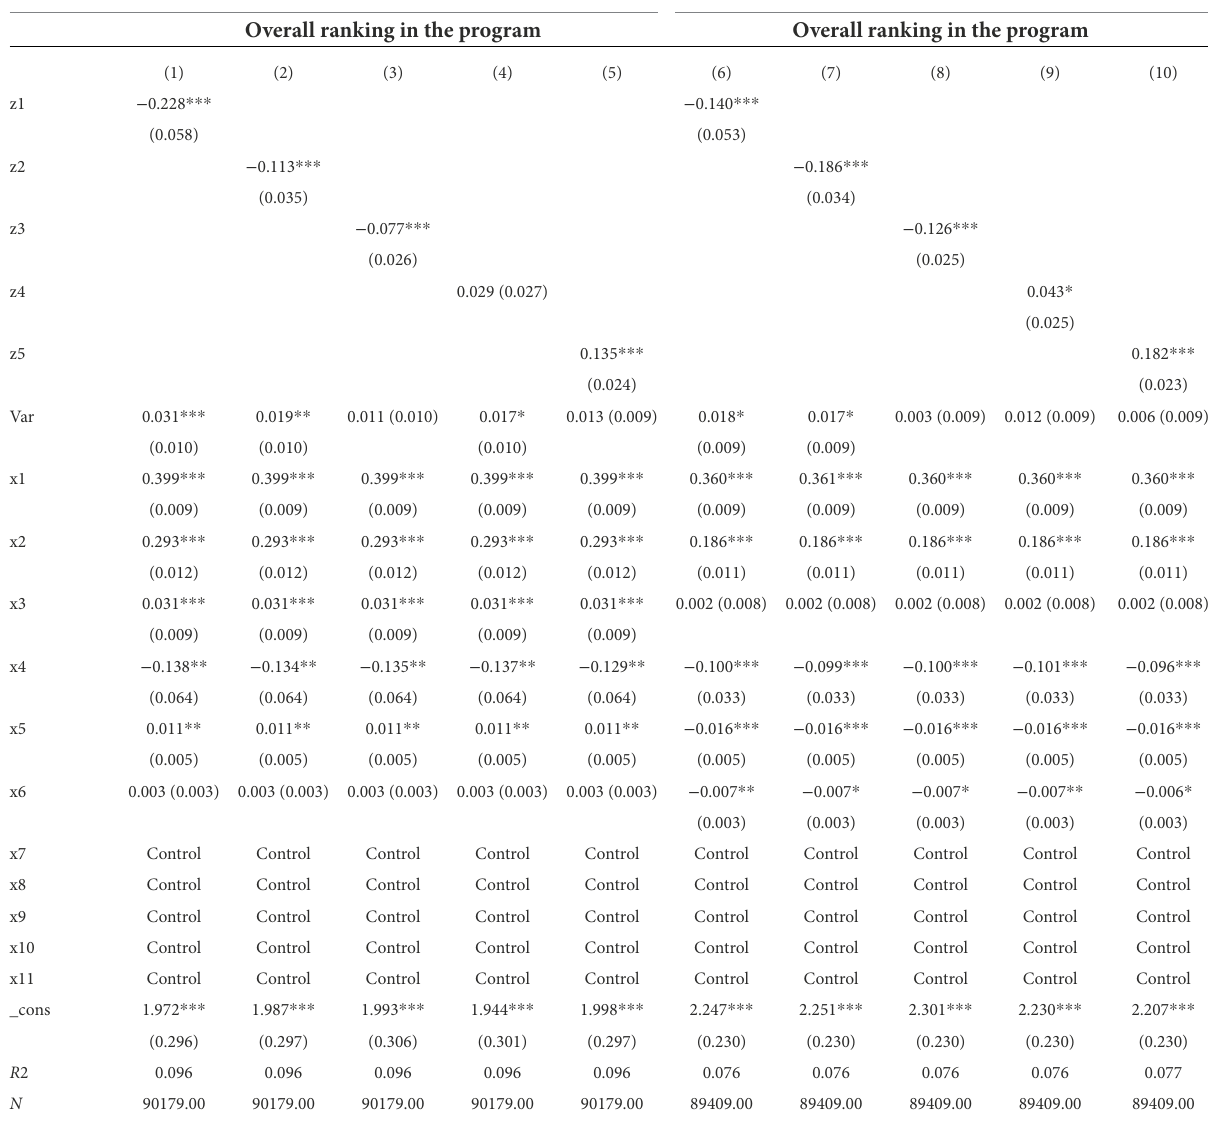
TABLE 4 Regression results of the ranking of individual students’ overall performance by gender